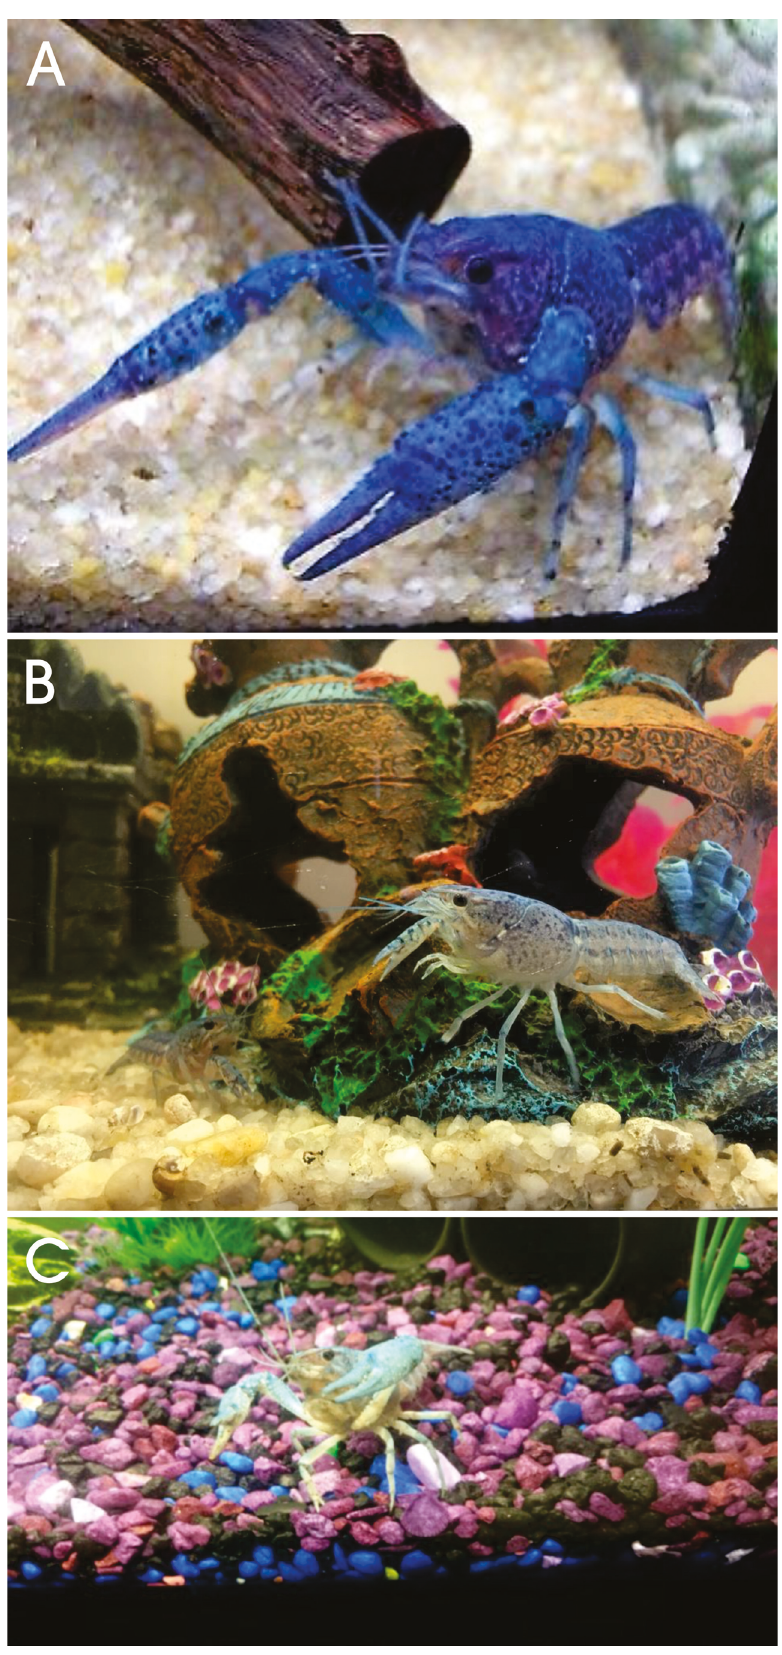
Figure 4. Crayfish that have probably been misidentified by their sellers. A–C, representative pictures of crayfish described as Cherax or “Australian” in online advertisements. All appear to be members of the North American genus Procambarus